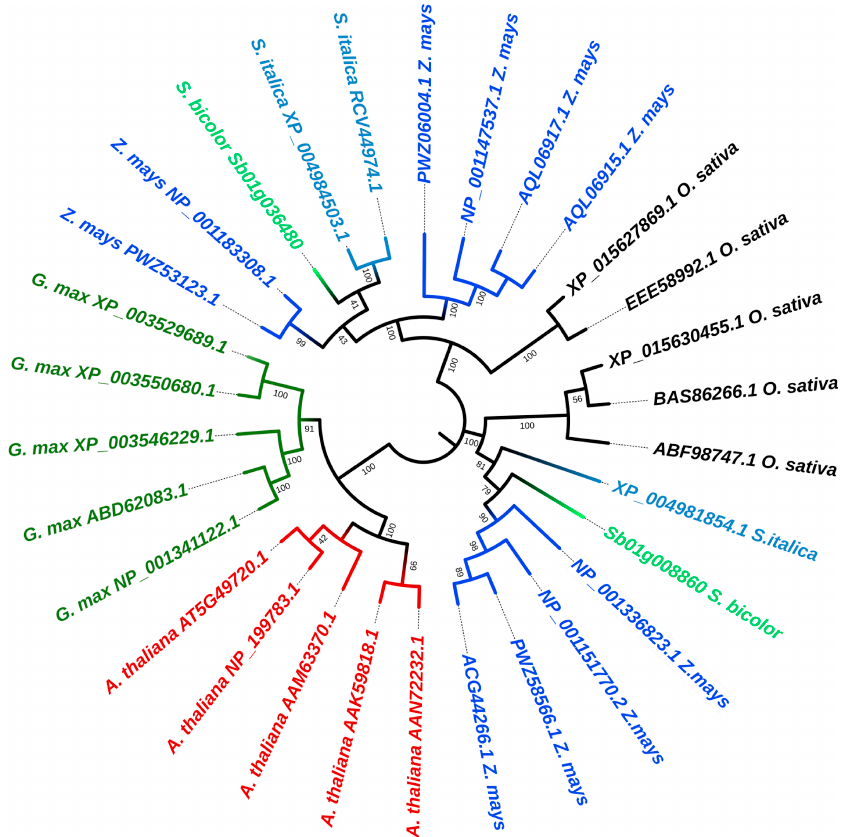
Figure 2. Phylogenetic analysis of KORRIGAN from different plant species. Maximum Likelihood phylogenetic tree of SbKOR1 in two dicots species and four types of grasses. SbKOR1 is highlighted. The tree placed SbKOR1 in the same clade as Z. mays endoglucanase 9, while its paralog was grouped with endoglucanase 10 protein from Z. mays . Phylogeny reconstruction was conducted with the Maximum Likelihood method, employing Jones-Taylor-Thornton (JTT) substitution model, and gramma distributed with invariant sites (G + I) method with 1000 bootstraps and visualized using the interactive tree of life (https://itol.embl.de/) accessed on 10 December